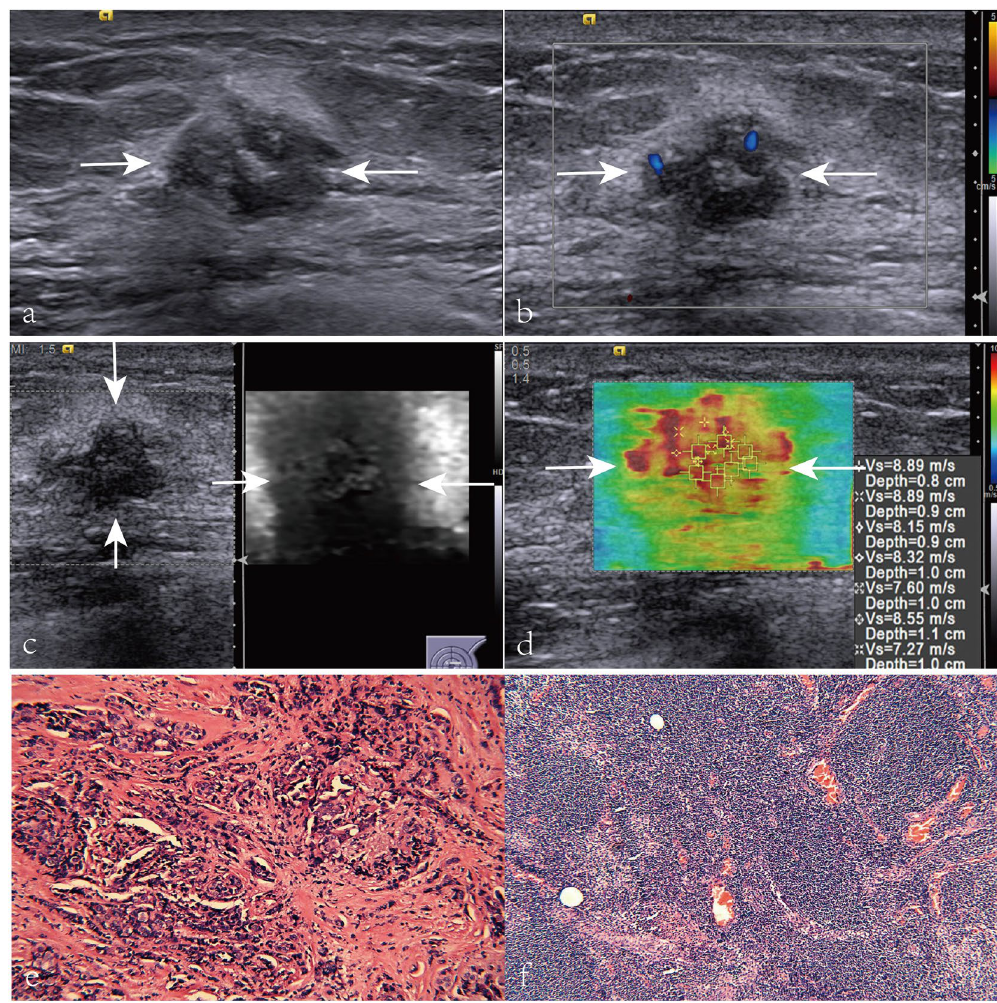
Figure 1. Images in a 60-year-old patient with breast invasive ductal carcinoma, no axillary lymph node metastasis (LNM), histologic grade II, positive estrogen receptor (ER), negative progesterone receptor (PR), and negative C-erbB-2. ( a ) A solid, heterogeneous hypoechogenicity, and poorly defined margin lesion (arrows) is shown on ultrasound (US). ( b ) Poor internal flow (i.e. dotted signals on color Doppler US) is found on color Doppler flow image (arrows). ( c ) Virtual touch tissue imaging (VTI) score of the lesion (arrows) is 3. ( d ) On virtual touch tissue imaging & quantification image, the lesion (arrows) is heterogeneous with a mean SWS value of 8.24 m/s. ( e ) Pathological examination confirms the diagnosis of invasive ductal carcinoma (Hematoxylin-eosin stain, x200). ( f ) Pathological examination confirms the diagnosis of normal lymph node (Hematoxylin-eosin stain,